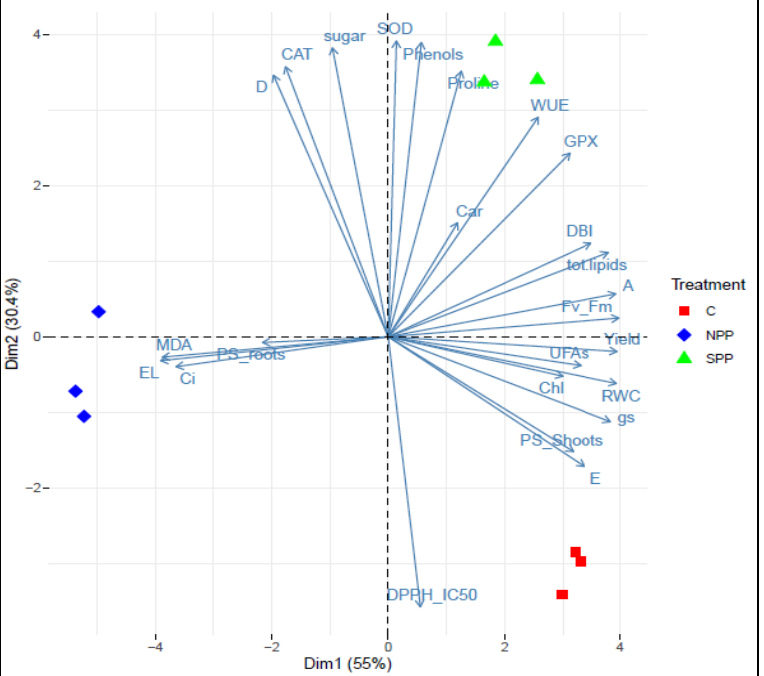
Figure 11. PCA biplot showing the clustering of nonprimed (NPP), salt-primed (SPP), and control (C) olive seedlings based on growth, physiological and biochemical traits. Shoot dry biomass production (PS shoots); root dry biomass production (PS roots); relative water content (RWC); net CO 2 assimilation (A), transpiration rate (E), stomatal conductance (gs), and intercellular CO 2 assimilation (Ci); water-use efficiency (WUE); maximum quantum efficiency of PSII (Fv/Fm); effective quantum yield of PSII photochemistry (Y); total chlorophylls (Chl); carotenoids (Car); leaf density (D); total sugar (sugar); proline (proline); lipid peroxidation (MDA); electrolyte leakage (EL); superoxide dismutase (SOD), catalase (CAT), and guaiacol peroxidase (GP); phenols(phenols); antioxidant activity (DPPH. IC50); total lipid content (tot. lipids); unsaturated-to-saturated fatty acid ratio (UFAs); double-bond index (DBI).